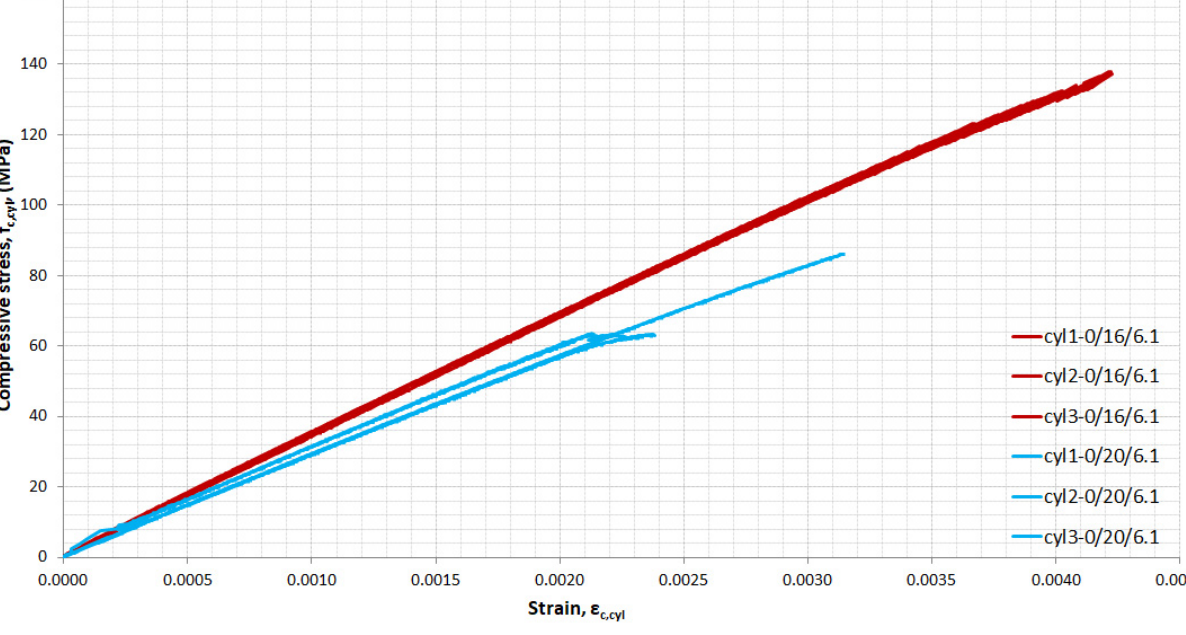
Figure 10. Stress–strain curves in compression for UHPFRC 2(0-2): The influence of w/b . In Figure 11, the influence of the quantity and length of fibres is presented. The mix- ture with 2% by volume 13-mm long fibres reached 135.3 MPa cylinder strength on aver- age and a corresponding strain equal to 4.3 × 10 − 3 . When the percentage of fibres was in- creased to 6% by volume, of which 5% were short 6-mm fibres and 1% were long 13-mm fibres, the cylindrical strength increased by 17.1%, with an ultimate strength of 158.4 MPa. The strain at ultimate strength was 5.6 × 10 − 3 . Replacing 2% of 6-mm-long fibres with 13- mm-long fibres in mixtures with 6% by volume, 6% (3-3) contributed significantly to the development of larger deformations in the plastic region (Figure 11). The replacement of